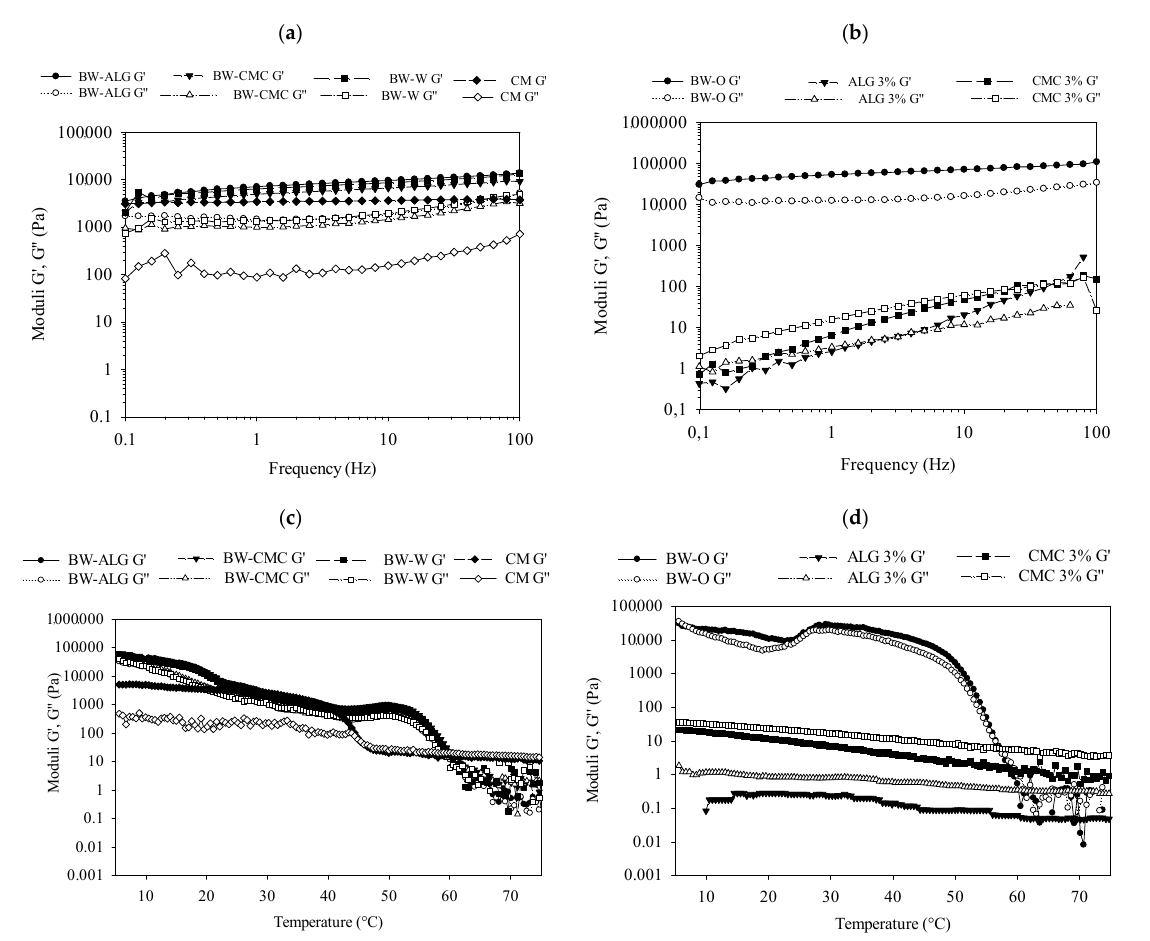
Figure 4. Rheological properties of bigels (BW-ALG and BW-CMC), oleogel (BW-O), sodium alginate hydrogel (ALG 3%), carboxymethylcellulose hydrogel (CMC 3%), emulsion of BW-O with distilled water (BW-W), and commercial margarine (CM): ( a , b ) moduli (elastic (G’) and viscous (G ″ )) during frequency sweep, ( c , d ) and moduli during temperature sweep. The thermodynamic properties of the bigels, evaluated by the temperature sweep test in the rheometer, showed that from an earlier stage of heating (5 °C), the moduli of the BW-ALG and BW-CMC bigels decreased (Figure 4c). A faster decrease in modulus was observed from approximately 50 °C in the bigels, to 70 and 67 °C for BW-ALG and BW-CMC, respectively; from these temperatures, G’’ was higher than G’, suggesting that the systems had turned into viscous or liquid matrices [10]. The BW-O showed a decrease in moduli from 5 °C. After 47 °C, a faster decrease was observed until 62 °C, suggesting a phase transition of samples occurred in this range (Figure 4d). At temperatures above 62 °C, the oleogels behaved like a liquid. Other authors have reported that the melting tem- perature of BW oleogels (at 8% BW concentration in medium-chain triglycerides or long- chain triglycerides such as oil phase or sunflower oil) is about 50–63 °C, but this temper- ature depends on BW concentration; as the oleogelator concentration increases, the melt- ing temperature increases [26,27]. The differences in the critical temperatures of bigels compared to pure oleogel suggest that alginate and CMC interactions could delay the